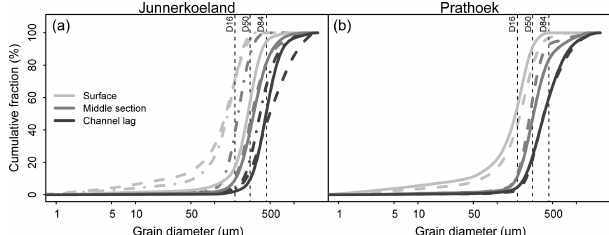
Figure 6. Cumulative grain size distributions of the scroll bar de- posits in (a) Junnerkoeland and (b) Prathoek. Three series were made for Junnerkoeland and two for Prathoek, each indicated by a different line type. Each sample within a series is indicated by a different grey tone. The averages of D 16 , D 50 , and D 84 are plotted. Figure 1c and d indicate the locations of the grain size